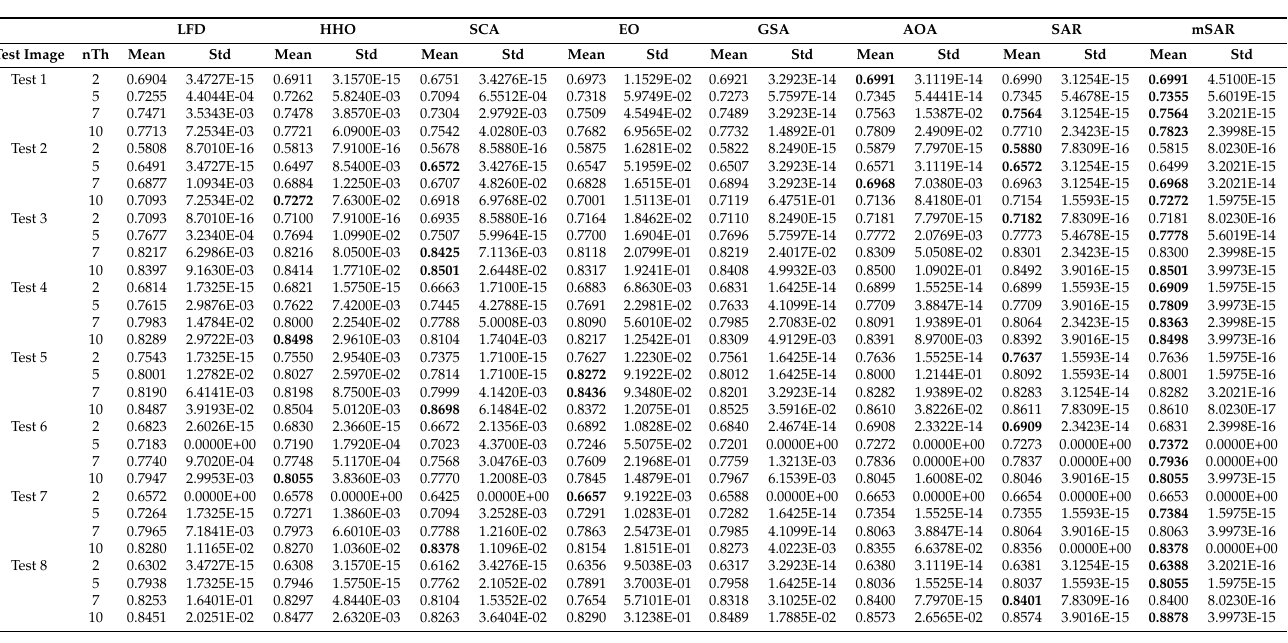
Table 6. mSAR fuzzy entropy in terms of SSIM values over all competed algorithms.